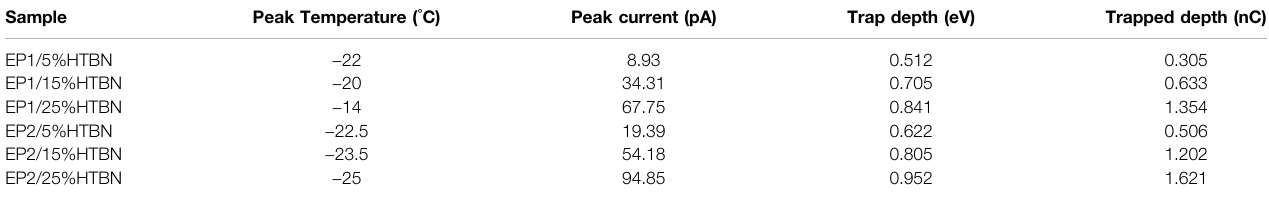
TABLE 1 | Trap characteristics of interfacial polarization under different formulations. Sample